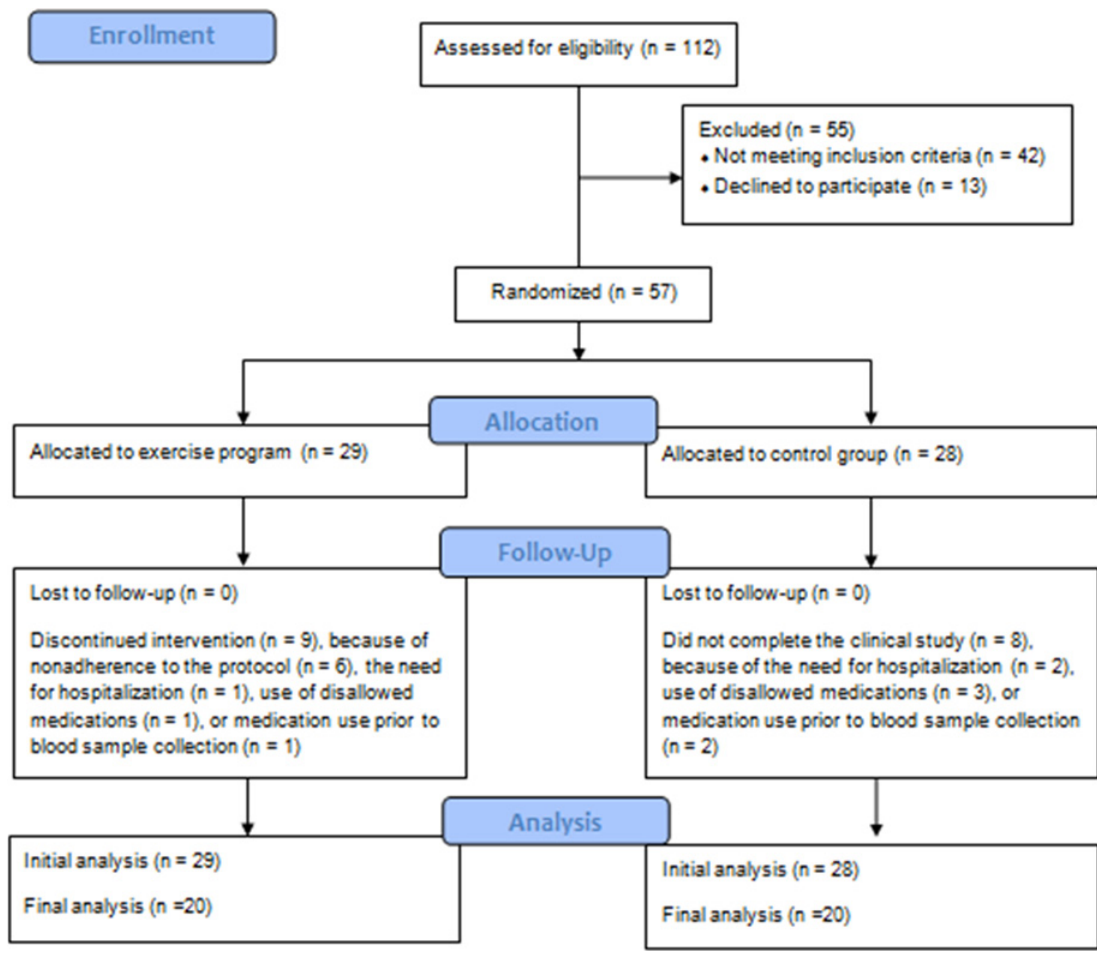
Fig 1. Flow chart of participants in the